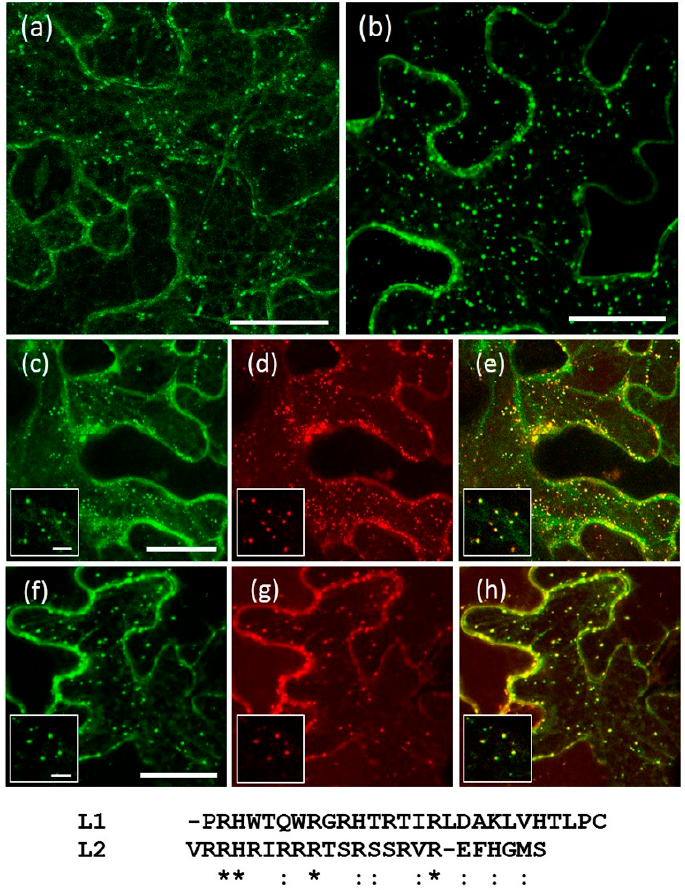
Figure 6. Localization of AtRMR1 and -2 with swapped transmembrane domains + linkers. Stacked confocal images of epidermal cells expressing AtRMR1 with the transmembrane and linker of AtRMR2 ( a ; AtRMR1TM2L2-GFP); or AtRMR2 with the transmembrane and linker of AtRMR1 ( b ; AtRMR2TM1L1-GFP). Stacked confocal images, excepted inserts ( c – h ; single images), of epidermal cells co-expressing AtRMR1TM2L2-GFP with AtRMR2-RFP ( c – e ) or co-expressing AtRMR2TM1L1-GFP with AtRMR2-RFP ( f – h ). GFP signal ( a – c , f ); RFP signal ( d , g ); and merged images ( e , h ). Scale bars = 30 µm; and 5 µm (inserts). An alignment of the linker sequences L1 and L2 is shown below the figure. (*) Identical amino acids; (:) amino acids with similar biochemical properties.